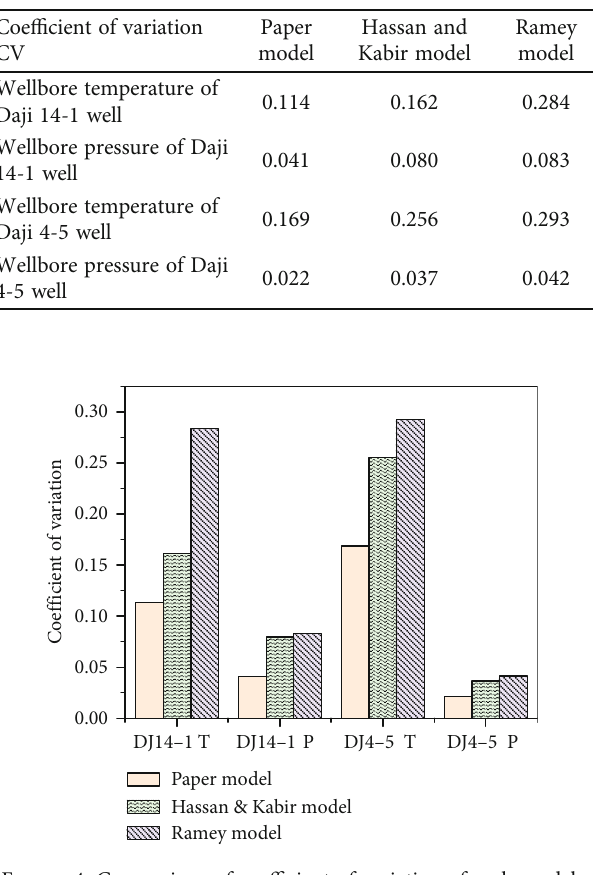
Figure 4: Comparison of coe ffi cient of variation of each